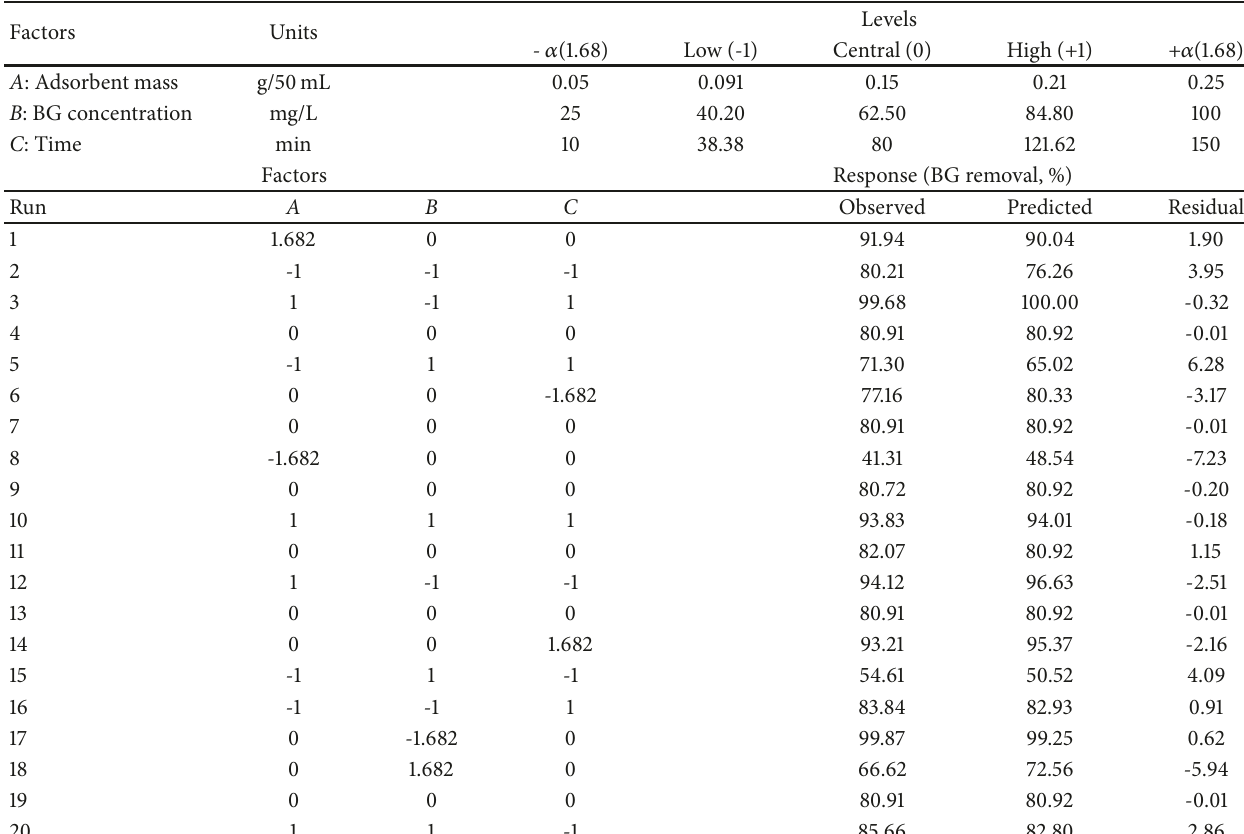
Table 7: Experimental parameters and levels in the CCD for the BG removal.